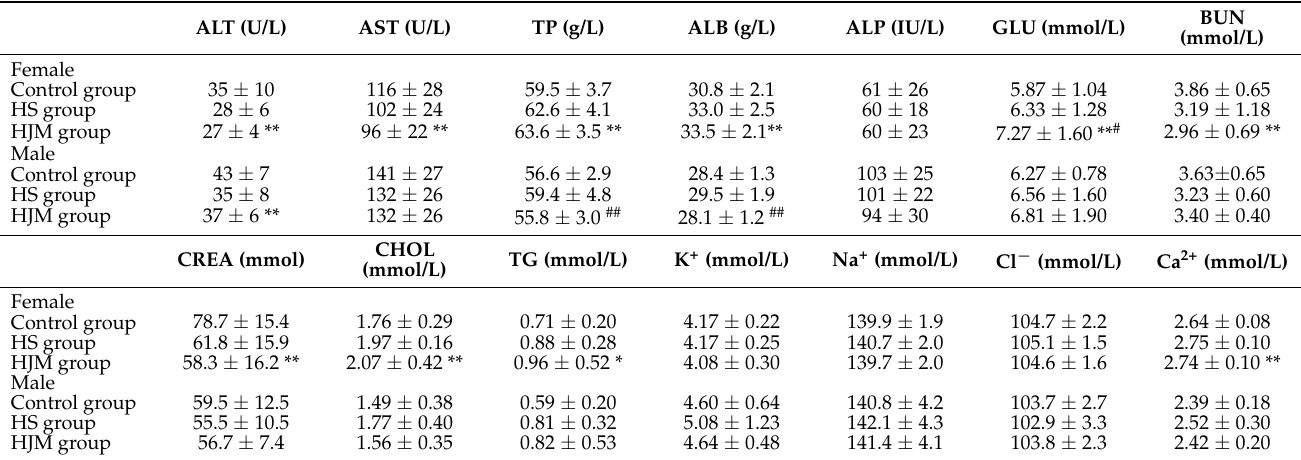
Table 4. Serum biochemistry parameters of male and female rats (mean ±